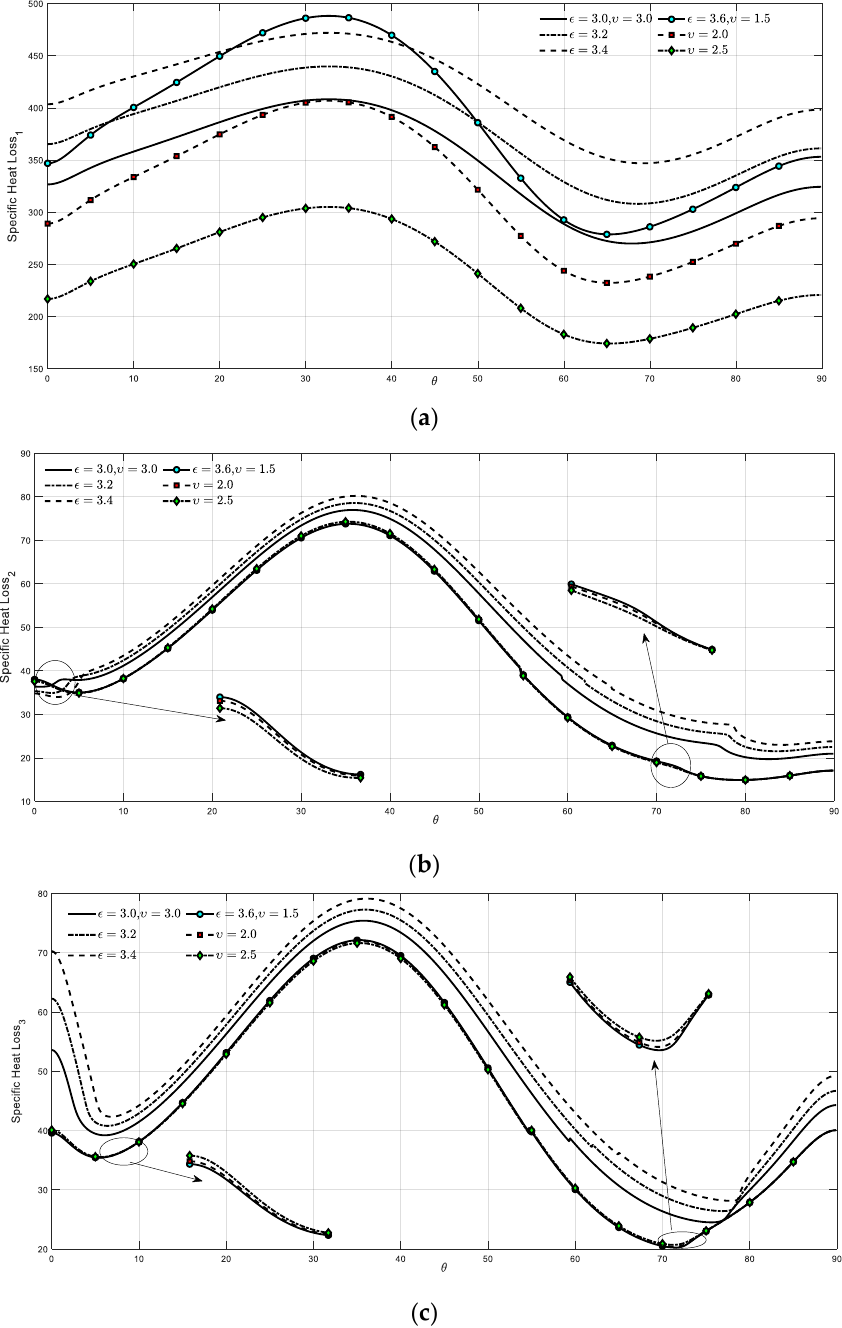
Figure 6. ( a ) Specific Heat Loss 1 for different angle of incidence; ( b ) Specific Heat Loss 2 for different angle of incidence; ( c ) Specific Heat Loss 3 for different angle of incidence.